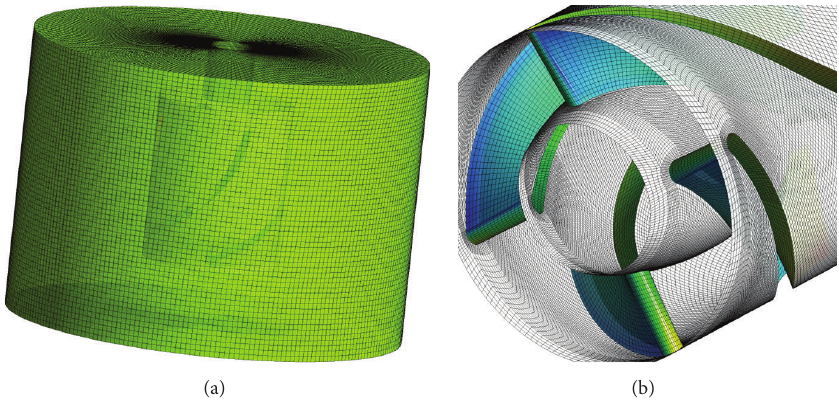
Figure 2: Mesh generation ((a): vessel and (b) details of impeller).